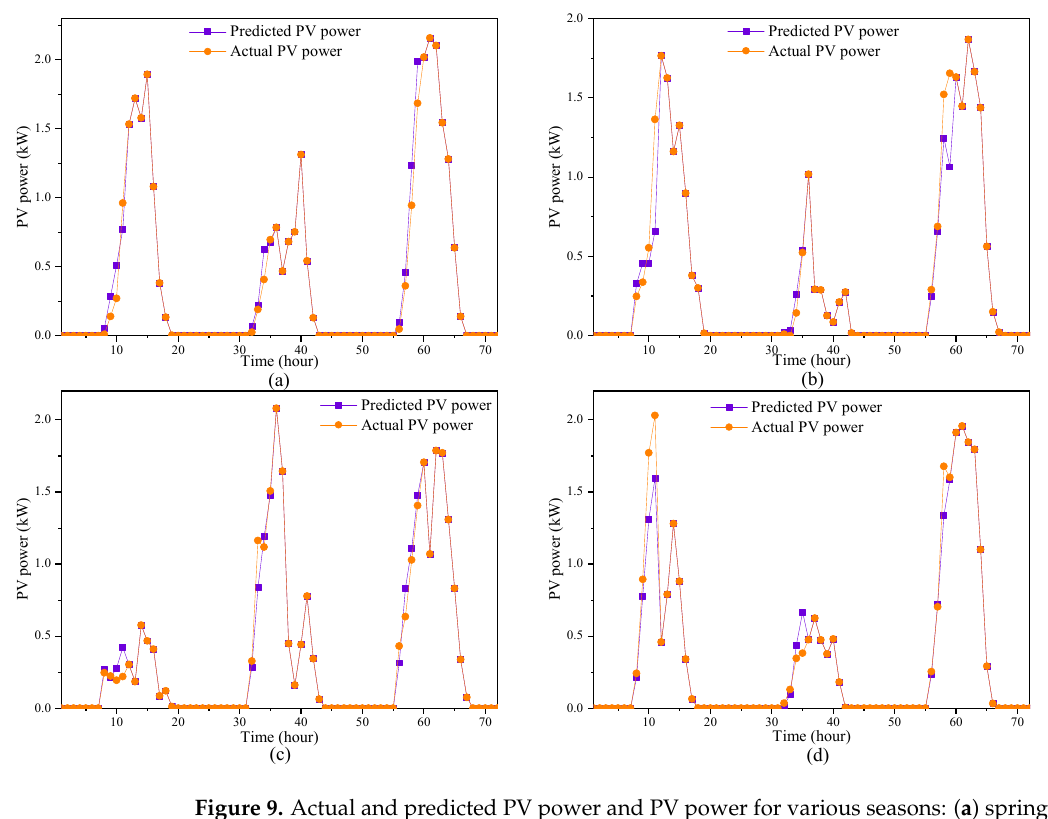
Figure 9. Actual and predicted PV power and PV power for various seasons: ( a ) spring; ( b ) summer; ( c ) autumn; ( d ) winter.